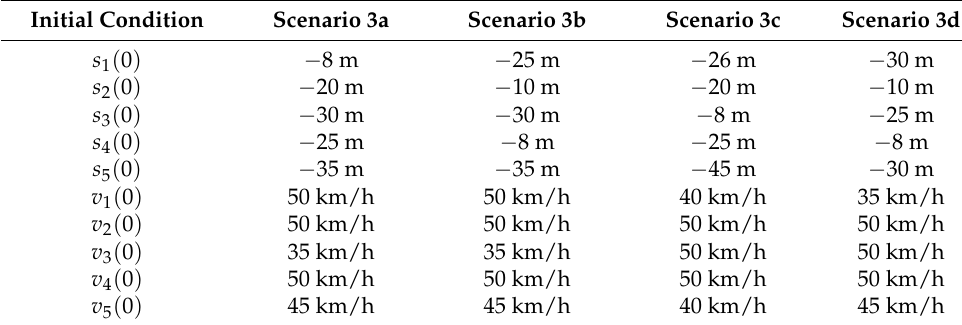
Figure 7. Illustration on the intersection scenario with 5 vehicles. Table 1. Initial conditions for scenario